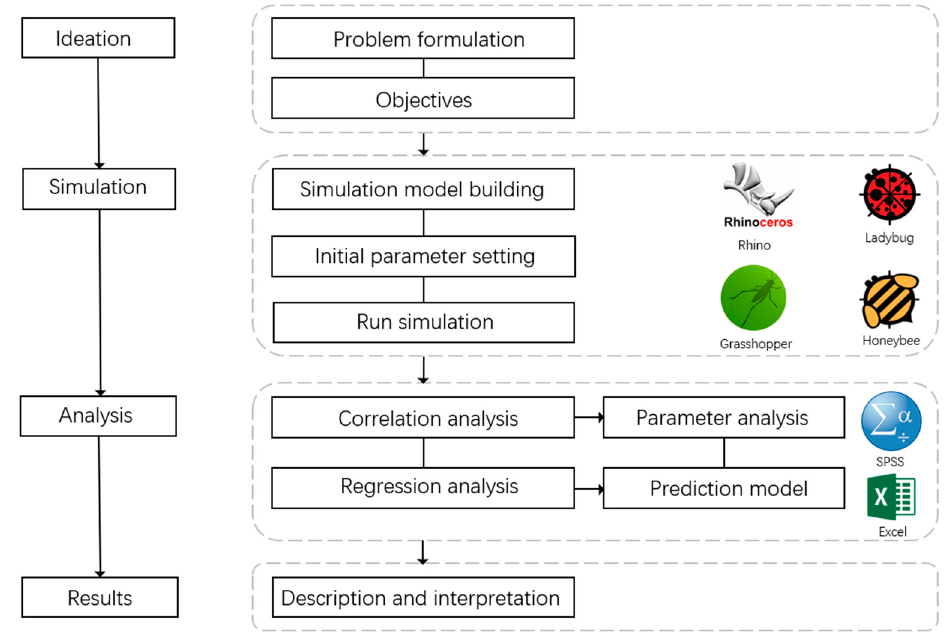
Figure 1. Research workflow.